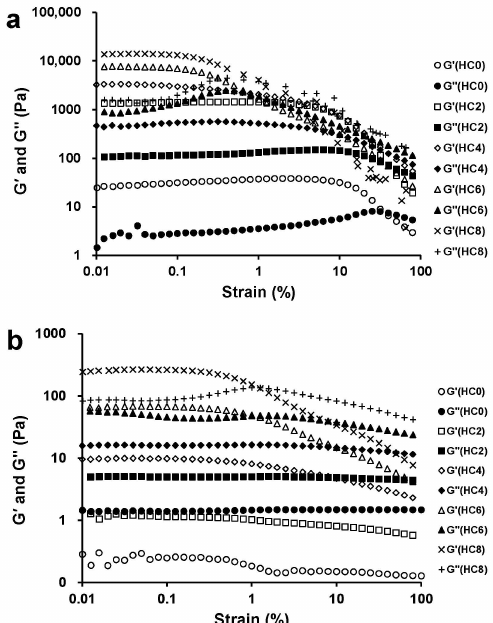
Figure 1. Strain sweep curves of hydroxypropyl methylcellulose/curdlan (HPMC/CL) blends at 82 ◦ C ( a ) and 25 ◦ C ( b